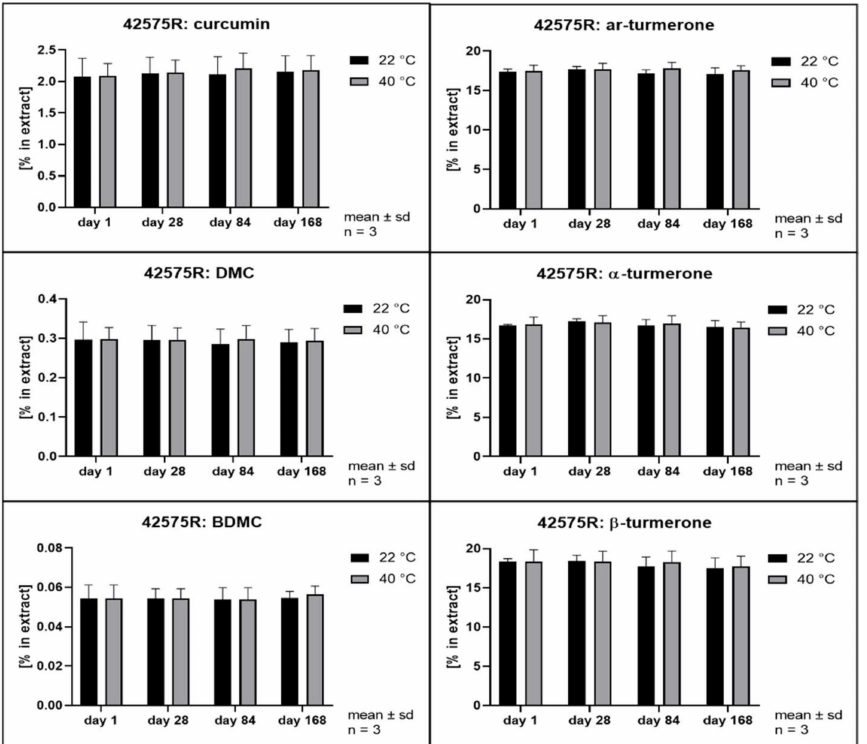
Figure 13. Contents of individual curcuminoids and turmerones in scCO 2 extracts throughout storage, extraction at 425 bar and 75 ◦ C, extract recovery via methanolic